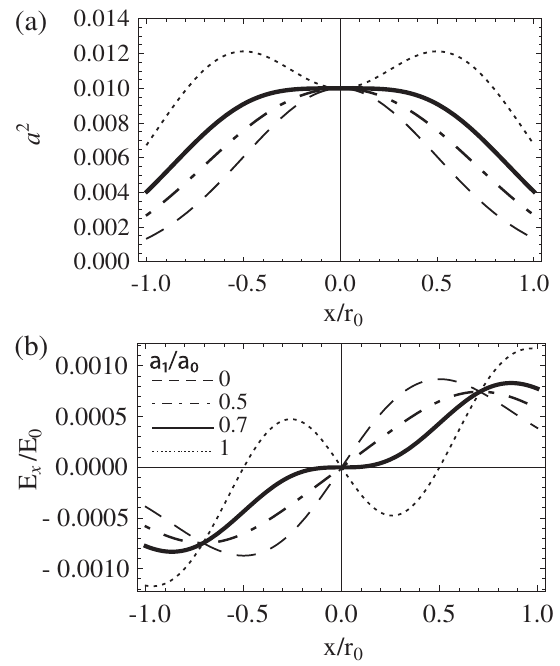
FIG. 4. (a) Transverse intensity profile when adding a funda- mental Gaussian mode of normalized intensity a 0 ¼ 0 : 1 and a first-order Hermite-Gaussian mode of normalized intensity a 1 , with cross polarization, and (b) corresponding transverse electric field (obtained from theory neglecting the plasma channel) (cid:4) ¼ (cid:3) (cid:1)= 2 , for a 1 =a 0 ¼ 0 (dashed line), a 1 =a 0 ¼ 0 : 5 at k ffiffiffi p p 2 (dash-dotted line), a 1 =a 0 ¼ 1 = (solid line), and a 1 =a 0 ¼ 1 (dotted line).